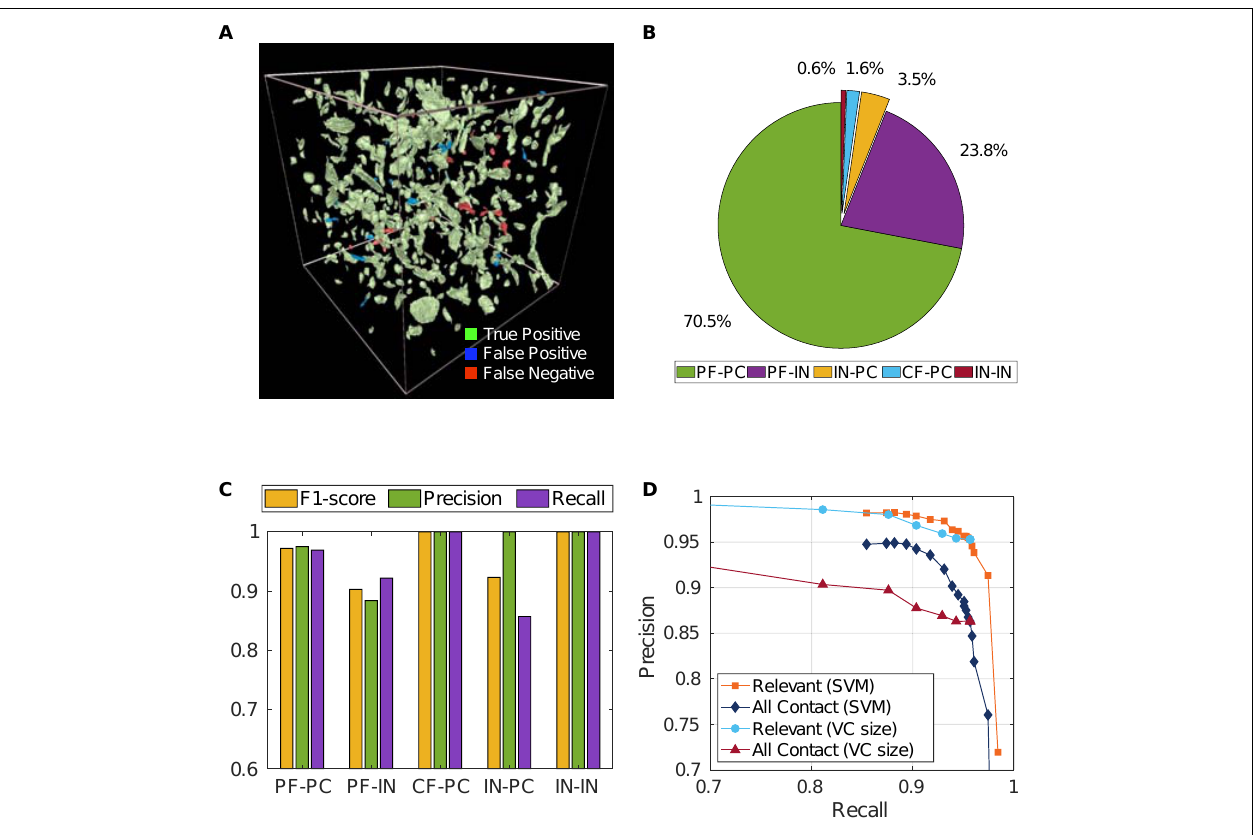
FIGURE 6 | Visualization of the accuracy. (A) The result of synapse classification for the test set is displayed in 3D mesh rendering. The contacts are color coded as true positive (green), false positive (blue), or false negative (red). (B) The proportion of the synapses by the types is shown in a pie graph. The PF-related synapses are absolutely dominant. (C) The accuracy measures by the types are shown in bar graphs. The PF-IN is the least accurate (90.3% F1-score) followed by IN-PC (92.3%) and then by PF-PC (97.2%). (D) The impact of the cell-type restriction step to select the relevant contacts is tested. The PR curves are shifted to down-left when all the contacts are used (the highest F1-score, 92.6%) compared to when the relevant contacts are used (95.5%), for both varying SVM thresholds and varying VC size thresholds. The cyan curve for relevant contacts for varying VC size thresholds is identical here and, in Figure 5D , serves as a